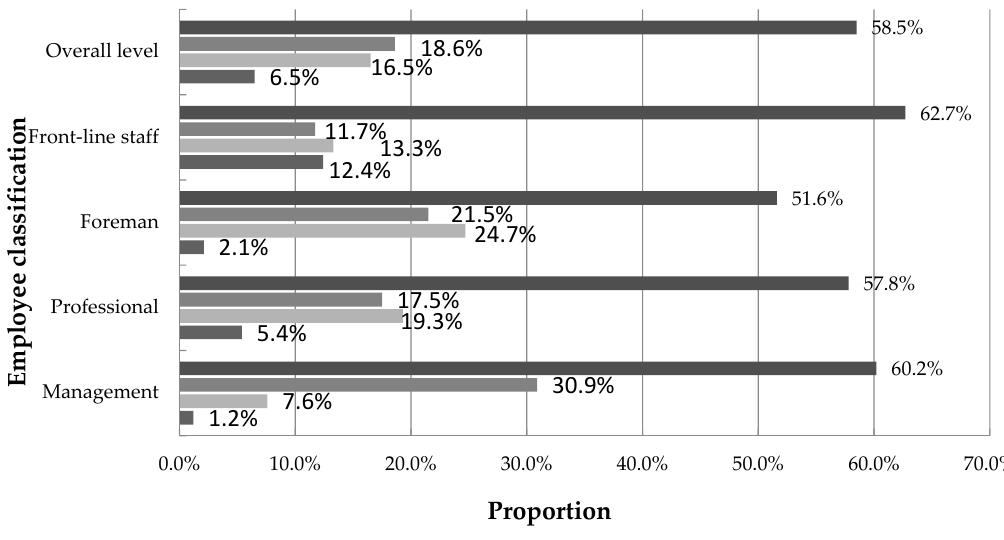
Figure 5. Basic situation of the working years of the tested employees.